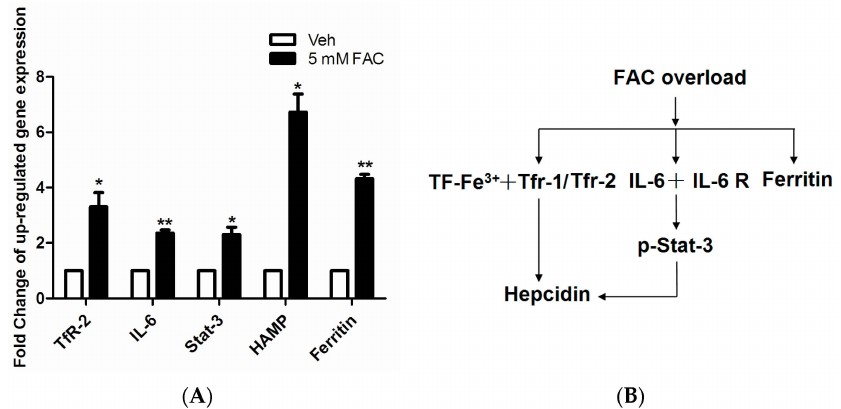
Figure 4. The effect of FAC overload on expression levels of iron homeostasis related gene. ( A ) FAC overload induced upregulation of iron homeostasis related protein expression. Expression of β -actin was used as internal control. Results are shown as mean ˘ SEM of three independent experiments. Statistically significant differences are labeled as * p < 0.05 and ** p < 0.01, compared with the control groups, using unpaired Student’s t test; ( B ) Schematic representation of the activation of Hepcidin regulation-associated signal transduction pathway in HH4 cells with FAC